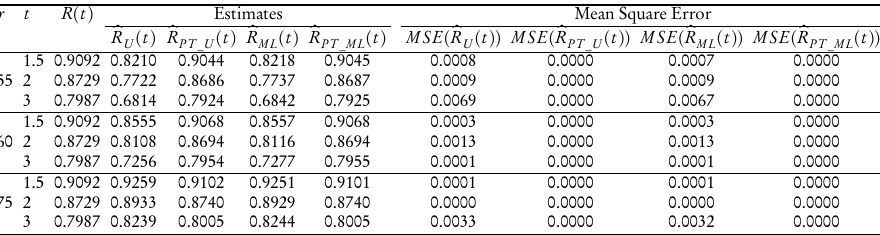
Estimates and corresponding mean square error of R ( t ) . The values are truncated to 4 decimal points, therefore few values in the column of mean square error being very small are mentioned as 0.0000.